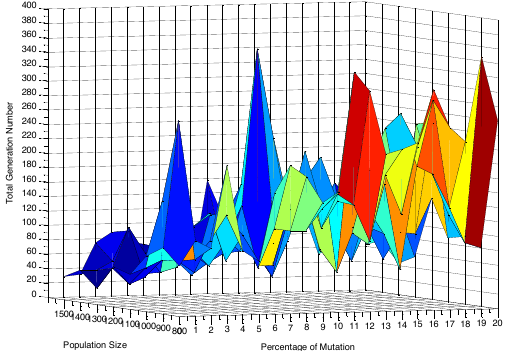
Figure 4.4.3 Maximum Fitness of All Highest Fitness